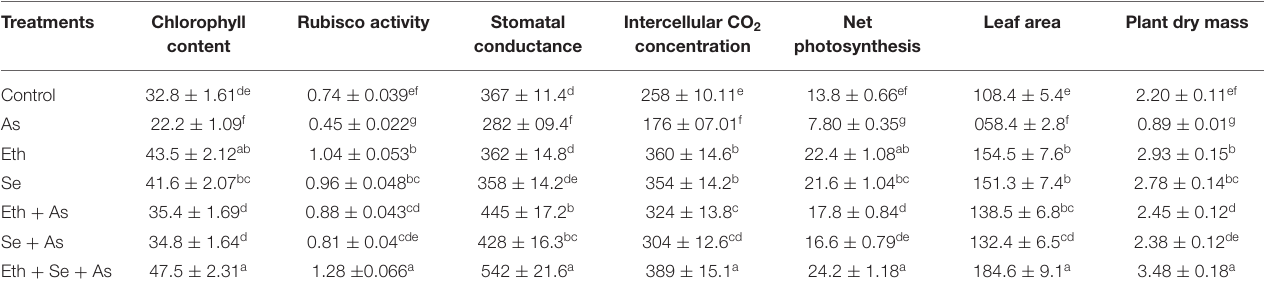
TABLE 3 | Chlorophyll content (SPAD value), Rubisco activity ( µ mol CO 2 mg − 1 protein min − 1 ), stomatal conductance (mmol CO 2 m − 2 s − 1 ), intercellular CO 2 concentration ( µ mol CO